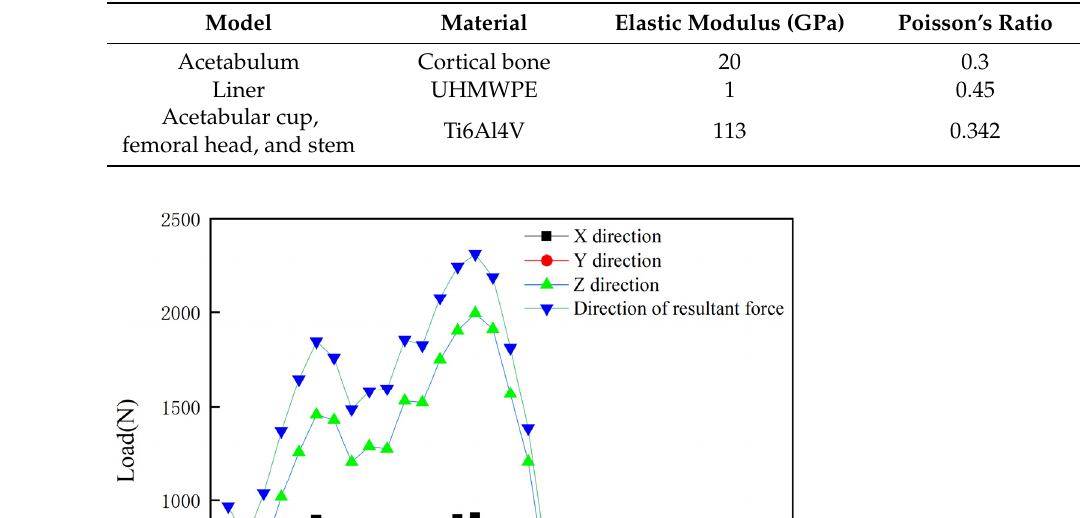
Figure 5. Joint loads at 32 transients of the gait cycle.